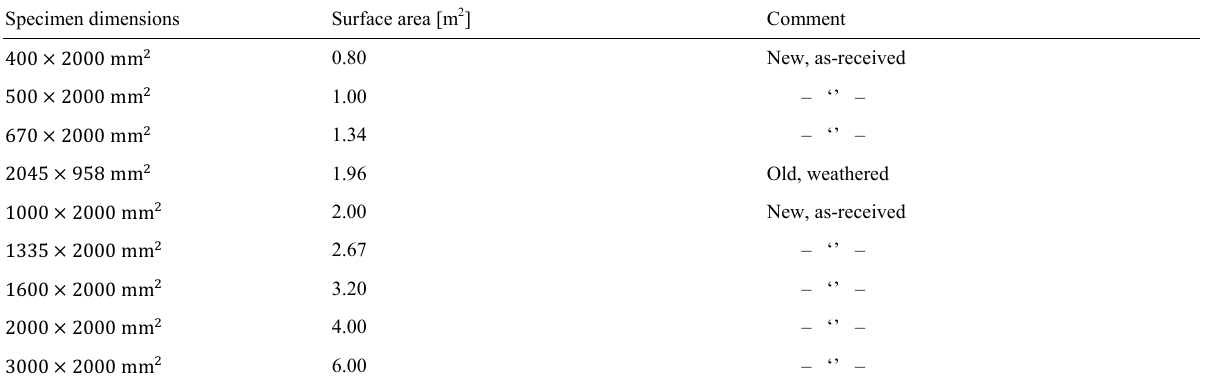
Table 5: Specimen dimensions in the experiments of Calderone et al. (2001) Specimen